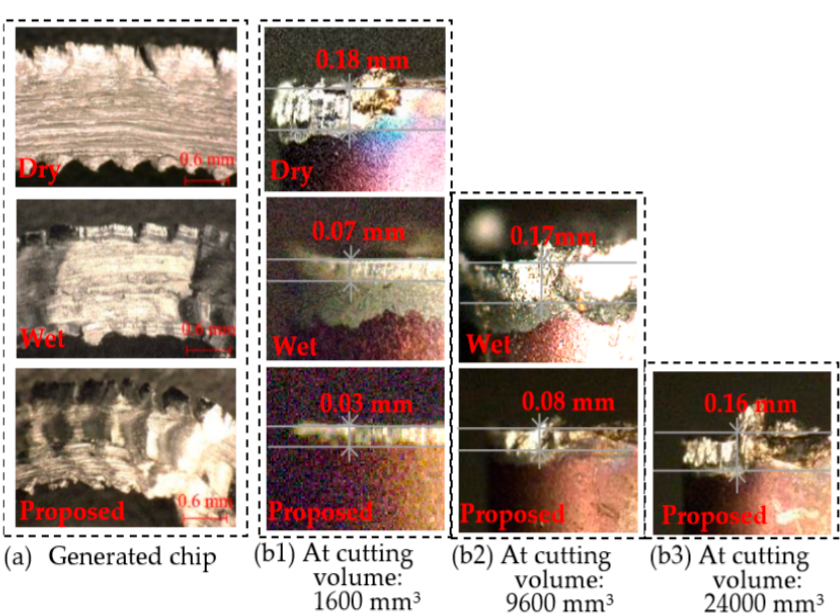
Figure 5. Photographs of ( a ) the generated chip using multiple cutting methods and ( b ) tool wear at their tool-life limit (Wet cutting pressure: 8 MPa, proposed system pressure: 20 MPa).